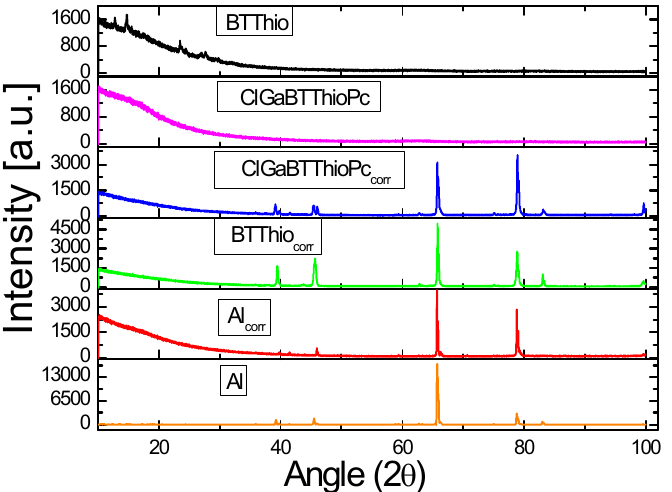
Figure 9. XRD patterns of: uncorroded aluminum metal (Al), aluminum metal after immersion in 1.0 M HCl (Al corr ), aluminum metal after immersion in 1.0 M HCl containing BTThio (BTThio corr ), aluminum metal after immersion in 1.0 M HCl containing ClGaBTThioPc (ClGaBTThioPc corr ) and inhibitors (ClGaBTThioPc and BTThio).